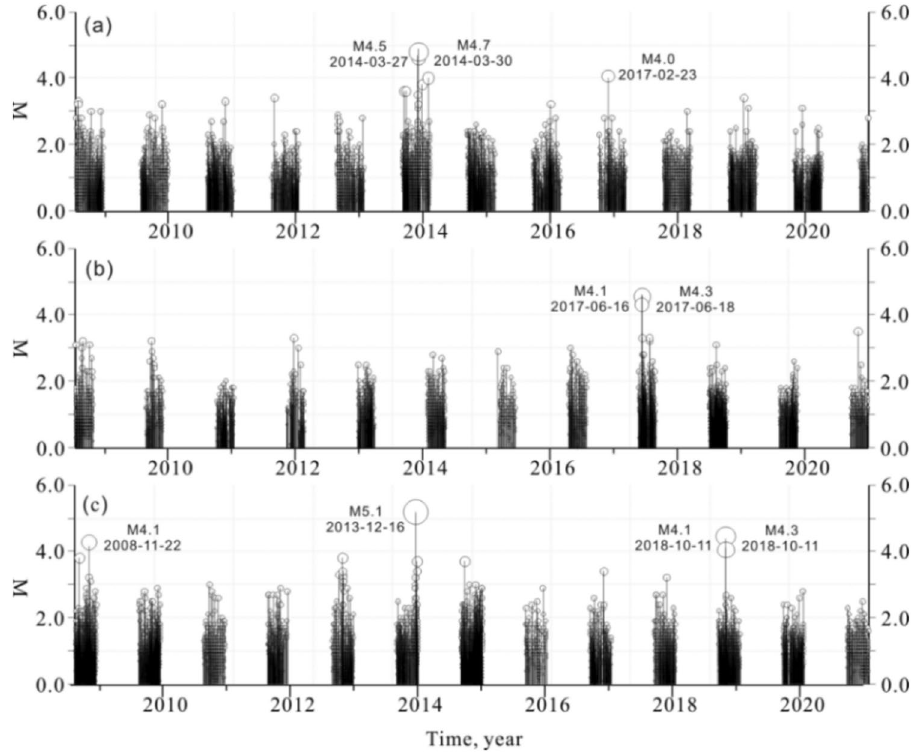
Figure 6. Characteristics of variation in earthquake magnitude in the reservoir area in different reservoir impoundment and discharge